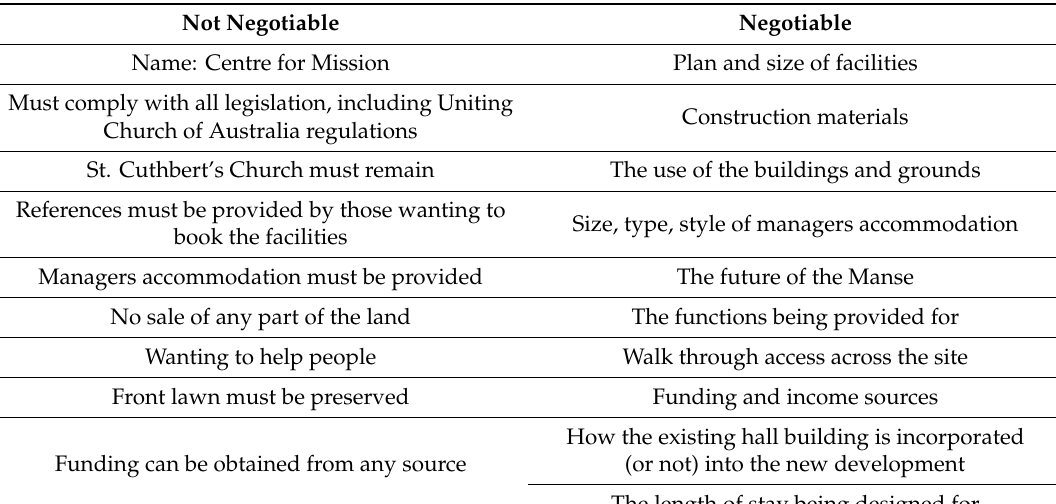
Table 1. St. Cuthbert’s Community Centre steering committee’s list of ‘Negotiable’ and ‘Not Negotiable’ project